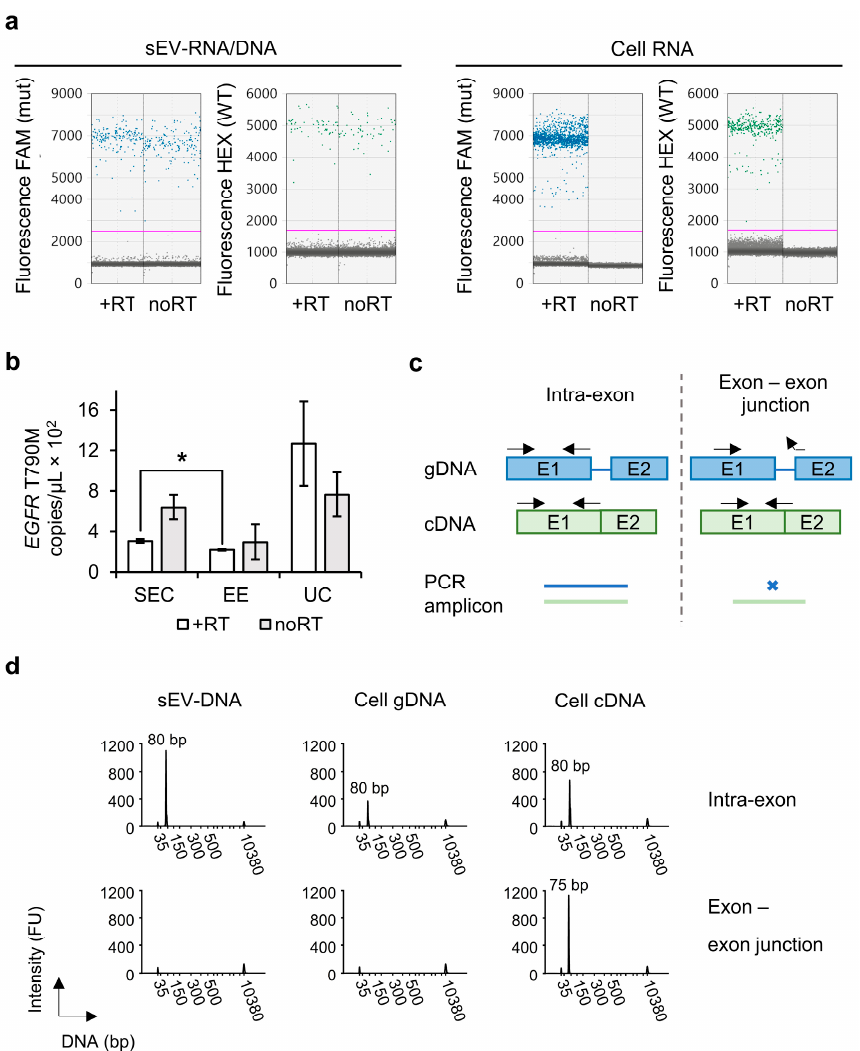
Figure 3. H1975 cell line sEV-derived genomic DNA provides a major template for EGFR T790M mutation detection. ( a ) Fluorescence intensities of mutant (FAM, mut) and wild-type (HEX, WT) obtained by a X200 Droplet Digital PCR System. Data are shown as 1D droplet amplitude with the threshold (pink line) separating positive from negative droplets. The sEV-derived RNA/DNA obtained by SEC and cellular RNA samples were used for cDNA synthesis using reverse transcriptase (+RT) or left untreated (noRT). ( b ) Concentration of EGFR T790M (copies/µL) in sEV-RNA/DNA obtained by ddPCR. Samples were prepared with reverse transcriptase step for cDNA synthesis (+RT, white) or left untreated (noRT, grey). Data obtained by SEC are compared to those of EE and UC methods. They are normalized to the same volume of conditioned culture medium used as starting material (90 mL) and represented as mean ± SEM (N = 3, n = 3). Statistically significant results are indicated by * for p -value ≤ 0.05. ( c ) The impact of PCR primer pair design on amplicon generation from gDNA (blue) and cDNA (green) containing both exons (boxes) and introns (lines) or only exons, respectively. Left: The intra-exon primer pair generates amplicons of the same length from both gDNA (blue) and cDNA (green). Right: The exon–exon junction primer pair generates an amplicon from cDNA, but not from gDNA. ( d ) Fragment length distribution profiles of PCR amplicons generated from sEV-RNA/DNA samples obtained by SEC, compared to cell-derived gDNA and cDNA. Intra-exon (top) and exon–exon junction (bottom) primer pairs were used for PCR. Analysis was done using a Bioanalyzer 2100 combined with the High Sensitivity DNA kit showing marker peaks at 35 bp and 10,380 bp. Small EV-derived samples were run undiluted and cellular samples were run after a 5-fold dilution. FU, fluorescence units; bp, base pairs.